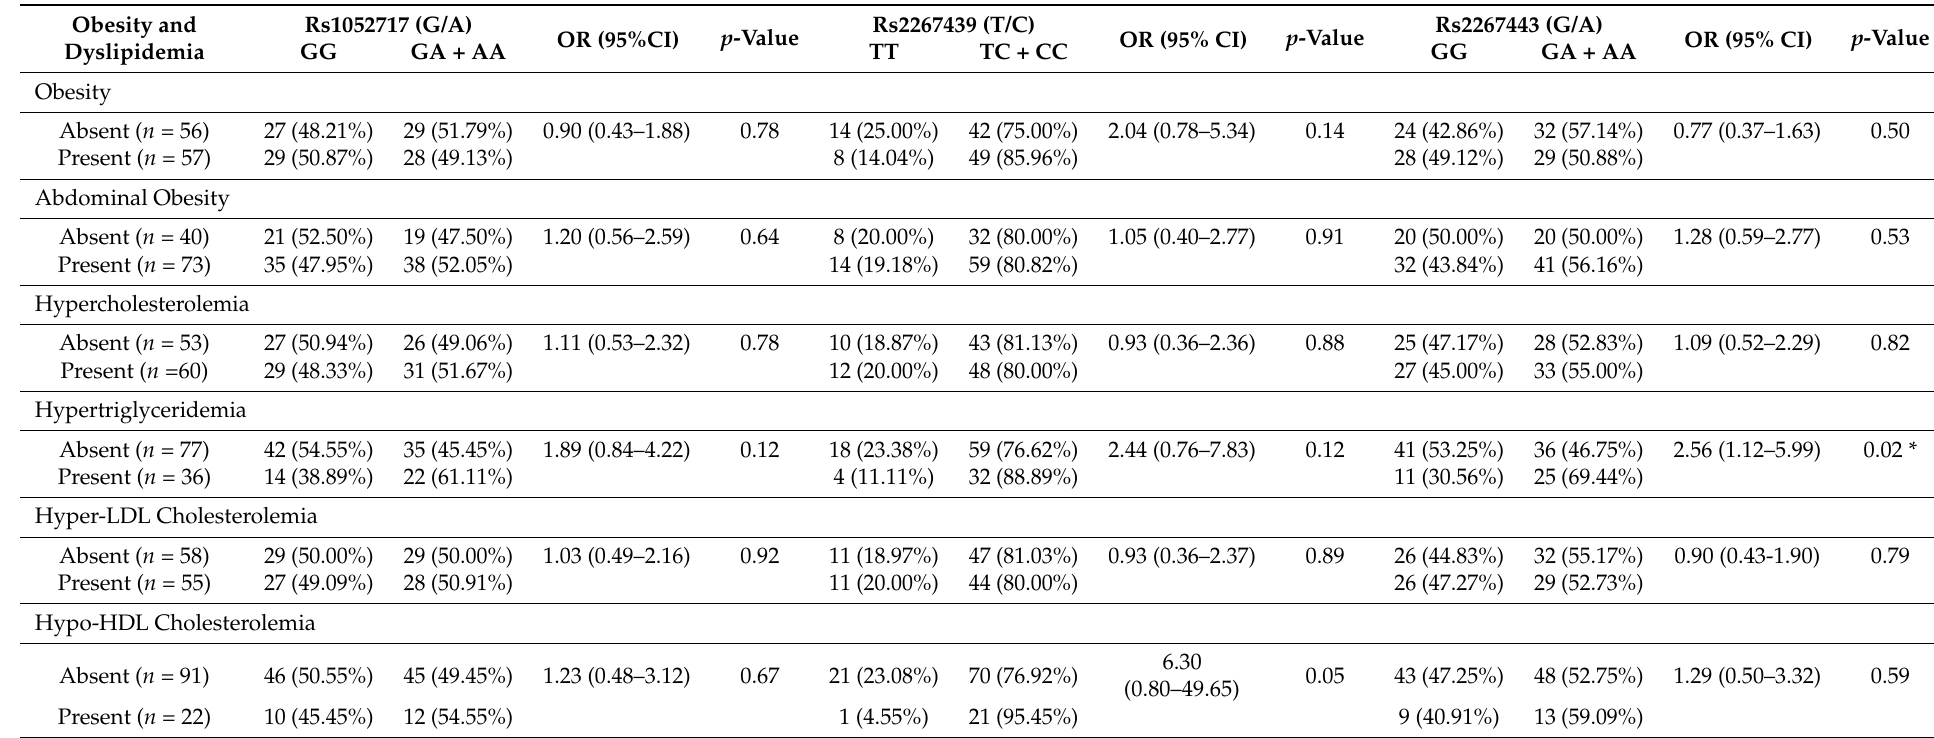
Table 3. Effect of the SREBF2 gene polymorphism on obesity and dyslipidemia ( n =